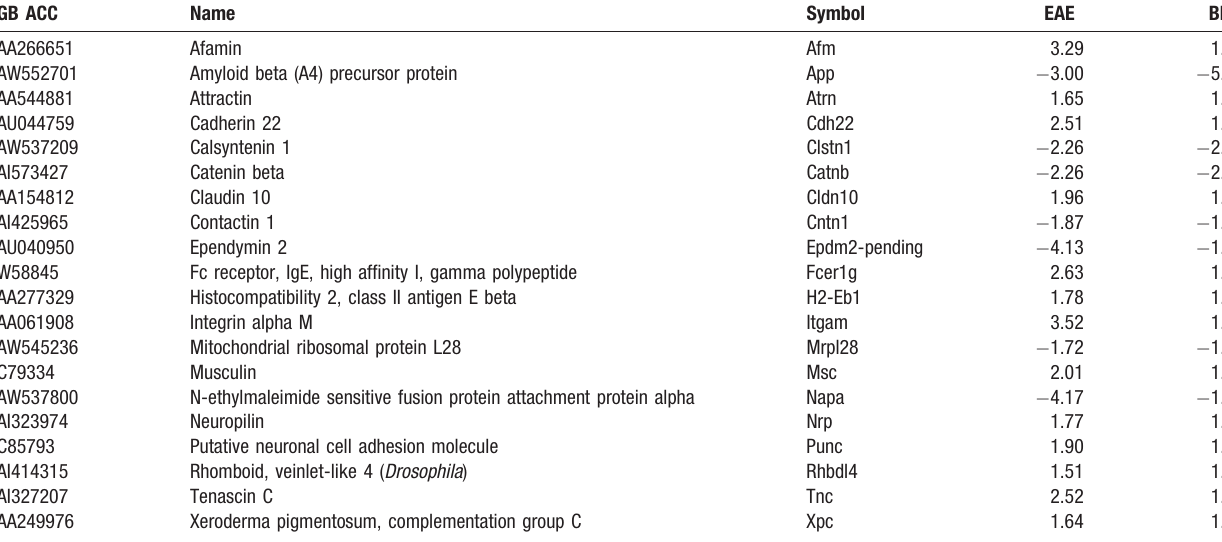
Table 2. Representative examples of significantly regulated JAE genes in EAE spinal cord (EAE) and in Cx43 null brain (BR). GB